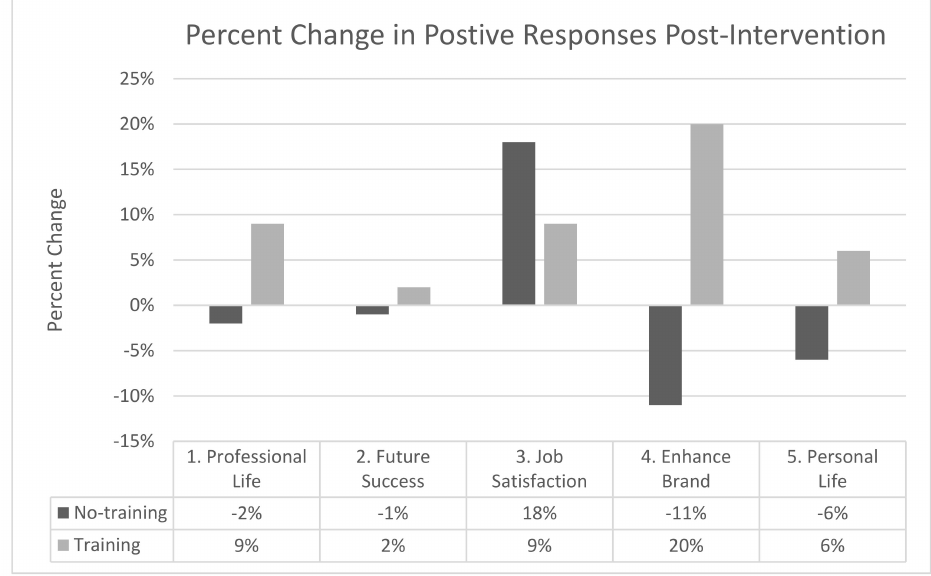
Figure 7. Percent change in positive responses for the sustainability engagement index items from the pre- to the post-intervention measurement time